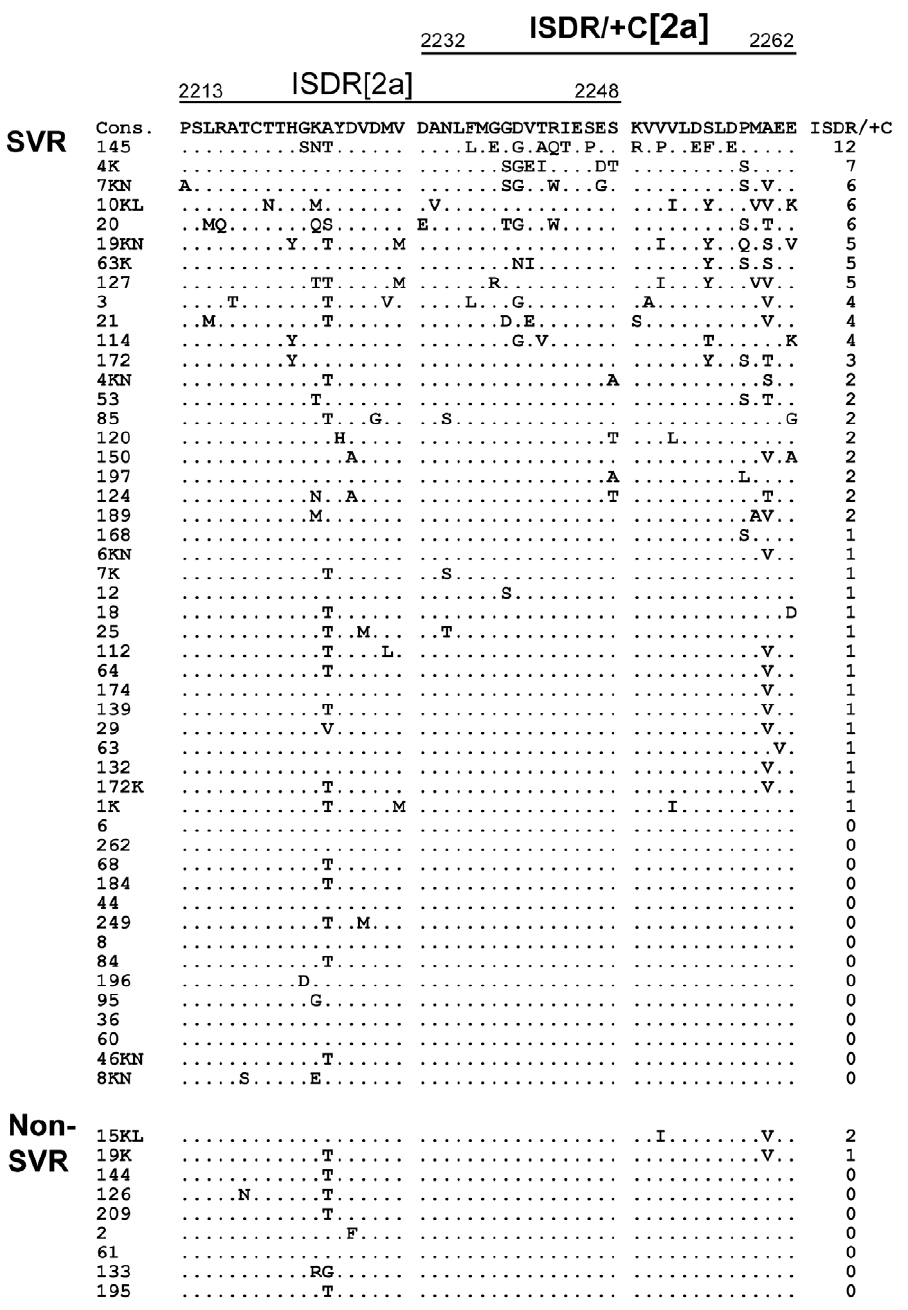
Figure 2. Sequence alignment of ISDR/ + C[2a]. Sequences of ISDR/ + C[2a] (part of interferon sensitivity determining-region plus its carboxy- flanking region of HCV-2a) obtained from SVR and non-SVR patients are aligned. The consensus sequence (Cons) is shown on the top. The numbers along the sequence indicate the aa positions. Dots indicate residues identical to those of the Cons sequence. The numbers of the mutations in ISDR/ + C[2a] are shown on the right.